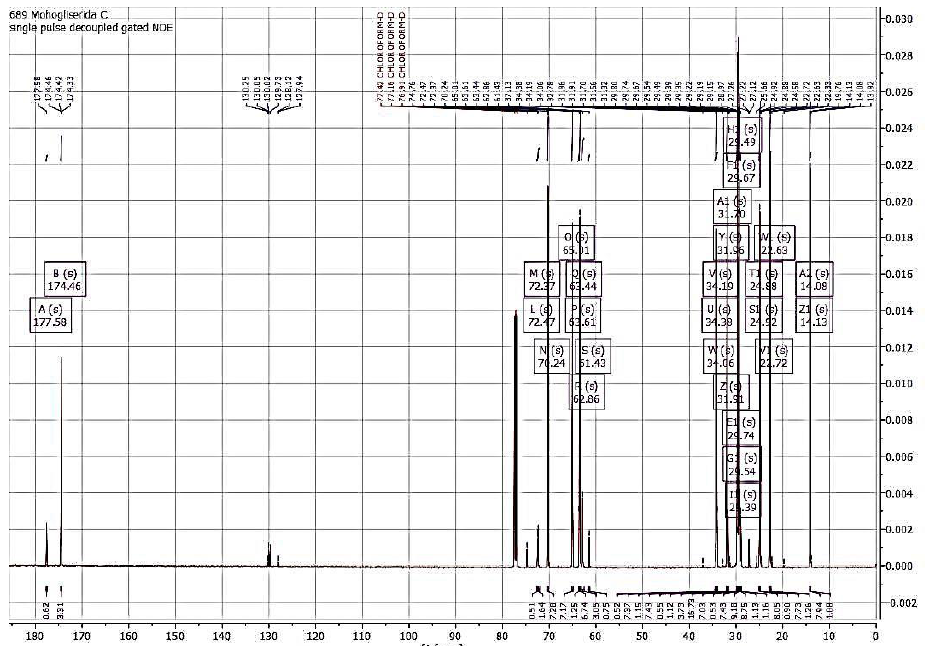
Figure 3. Spectrum 1 H NMR of monolaurin from glycerolysis reaction of PKOo-PKS blend with a ratio of 40:60 w/w for 24 h, at 40 °C, molar ratio of oil to glycerol 1:4, solvent to oil ratio of 2:1 v/w , enzyme concentration of 10% w/w , and stirring speed 600 rpm.